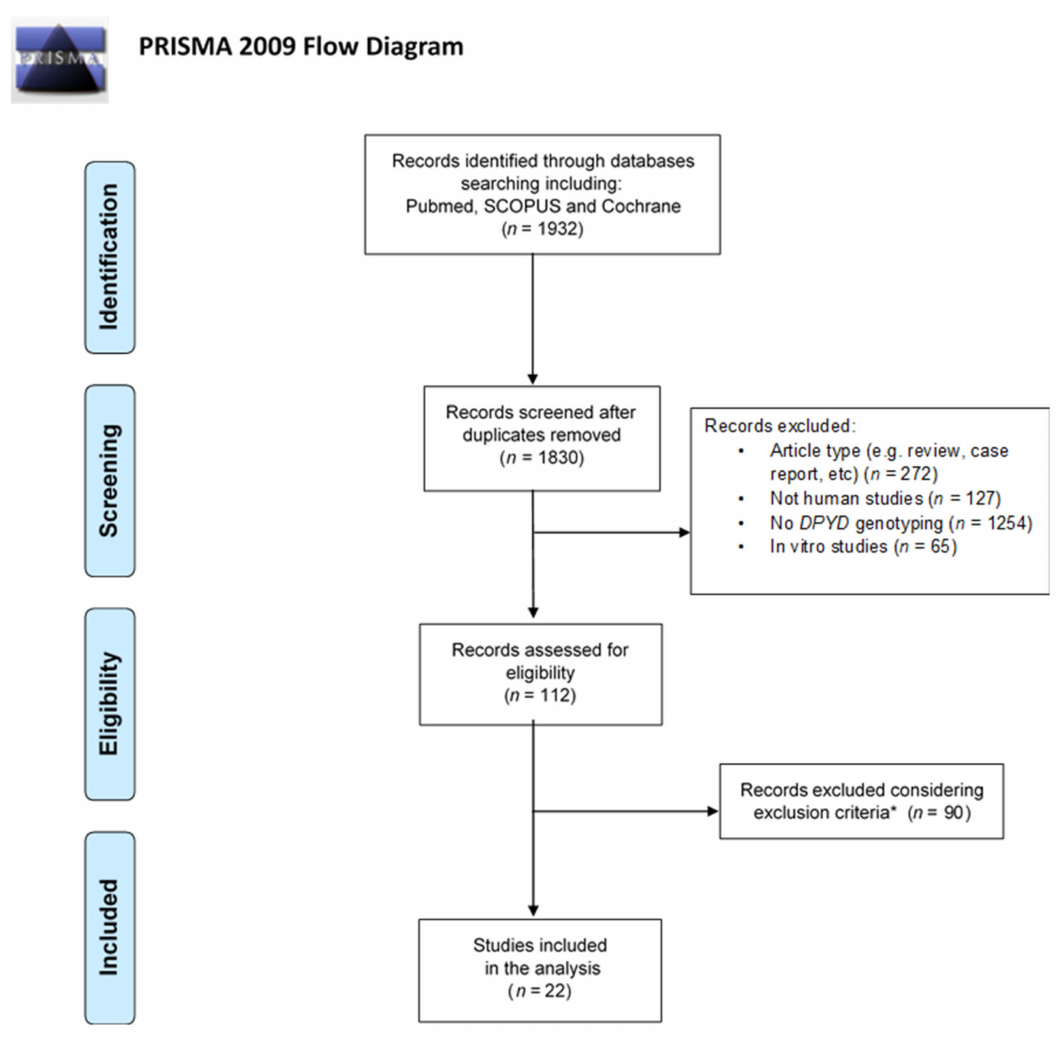
Figure 1. Flowchart of the databases searched. * Exclusion criteria: (1) studies not including at least one of the four recommended DPYD polymorphisms and (2) other study designs (e.g., allelic frequencies estimation, no patients and methods for